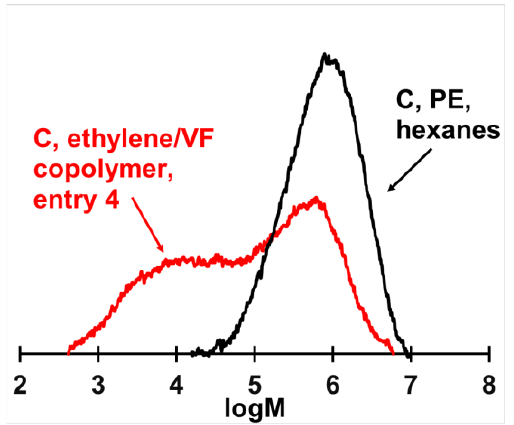
Figure 2. Molecular weight distributions of polyethylene (PE) [39] and ethylene / VF copolymer (Table 1, entry 4) generated by C determined by high temperature GPC. Polymerization conditions: hexanes solvent, 80 °C.